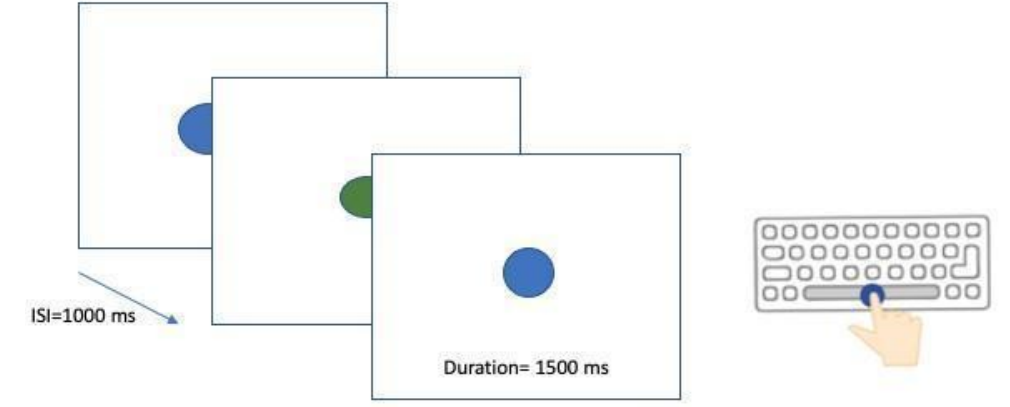
Figure 3. Exemplification of the 2-back